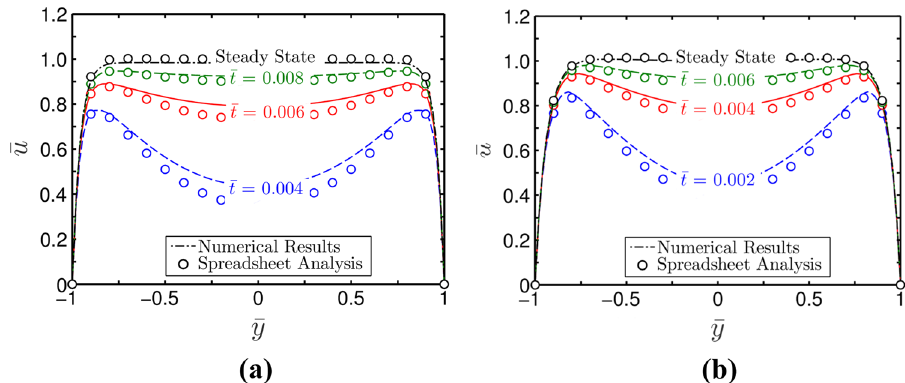
Figure 7. Plots depict velocity profile at different instances of time at z = 0 . The parameters used for these temporal variations are κ = 20 , and Ŵ = 0 for ( a ) n = 0.8 and ( b ) n = 1.2 . The MATLAB solutions are represented by solid lines, whereas the spreadsheet analysis tool-derived solutions are shown by markers.